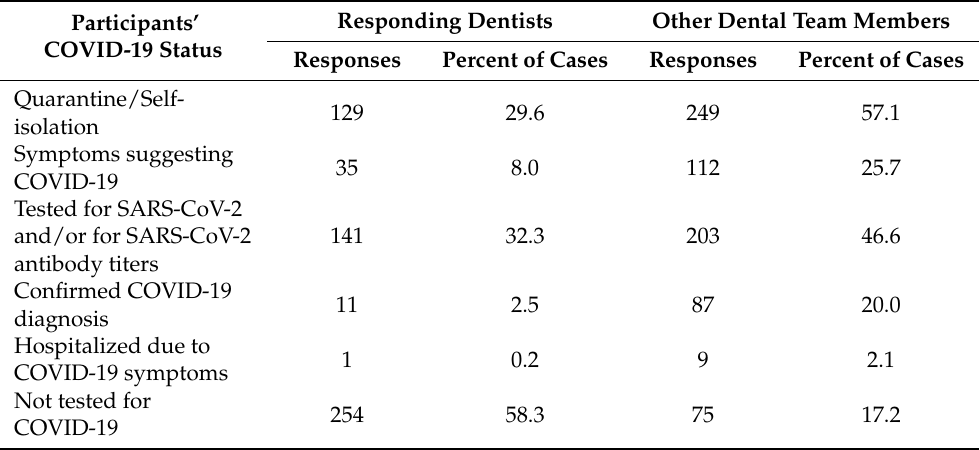
Table 3. History of COVID-19 infection amongst responding dentists ( n = 436) and team